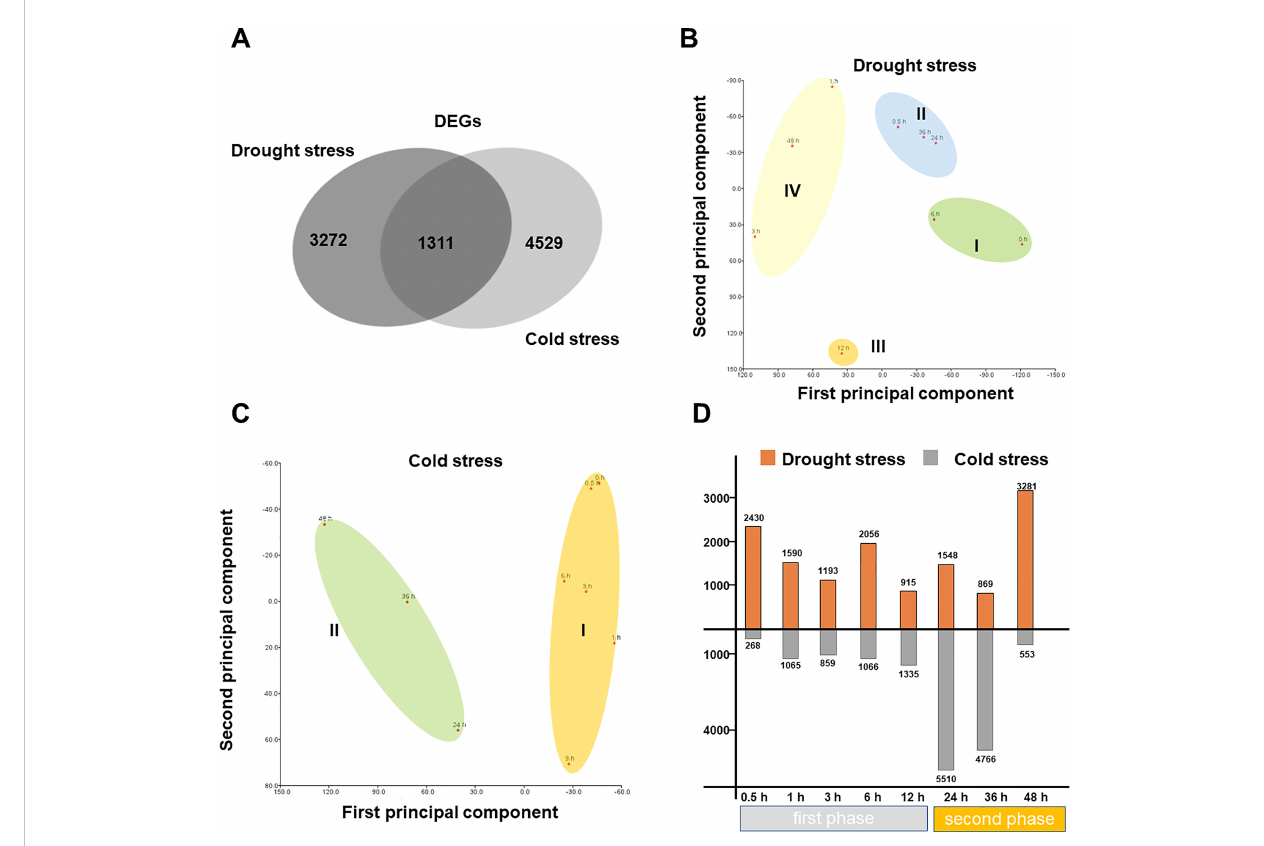
FIGURE 2 Temporal dynamics of M. rubra transcriptome during drought and cold treatment. (A) Venn diagrams of DEGs overlapping between drought stress and cold stress. DEG indicates dfferentially expressed gene. (B) PCA of the transcriptomes of the 8 time point samples under drought stress and (C) cold stress. (D) Number of drought-responsive (upper bars) and cold-responsive (lower bars) genes at each time point compared to the control group (0